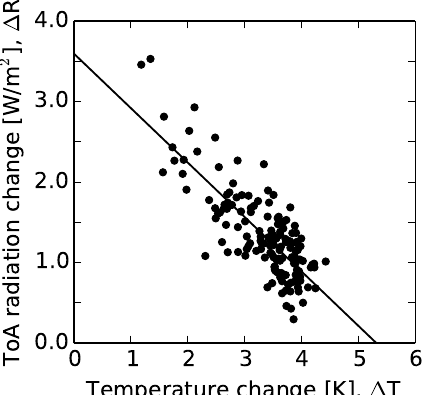
Figure 3. Evolution of radiative flux at the top of the atmosphere with temperature changes at the surface in the dark desert world of the early Eocene climate. At the beginning of the simulation, savanna-like vegetation is replaced by bare soil with an albedo of 0.1. The first 150 simulated years are shown. The black line is the fitted regression